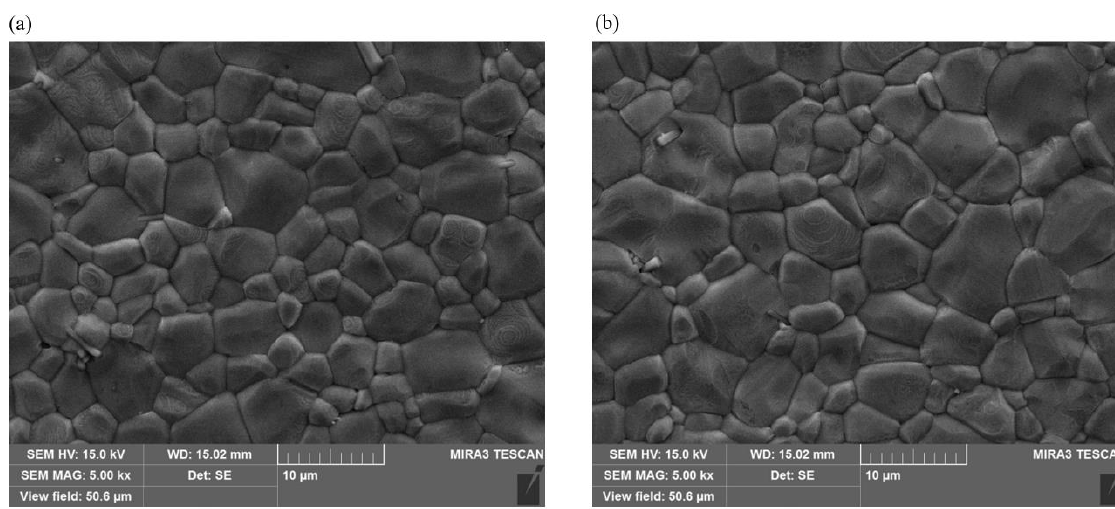
Figure 4. Surface morphology of sintered sample: ( a ) LSM-F and ( b ) LSM-K.